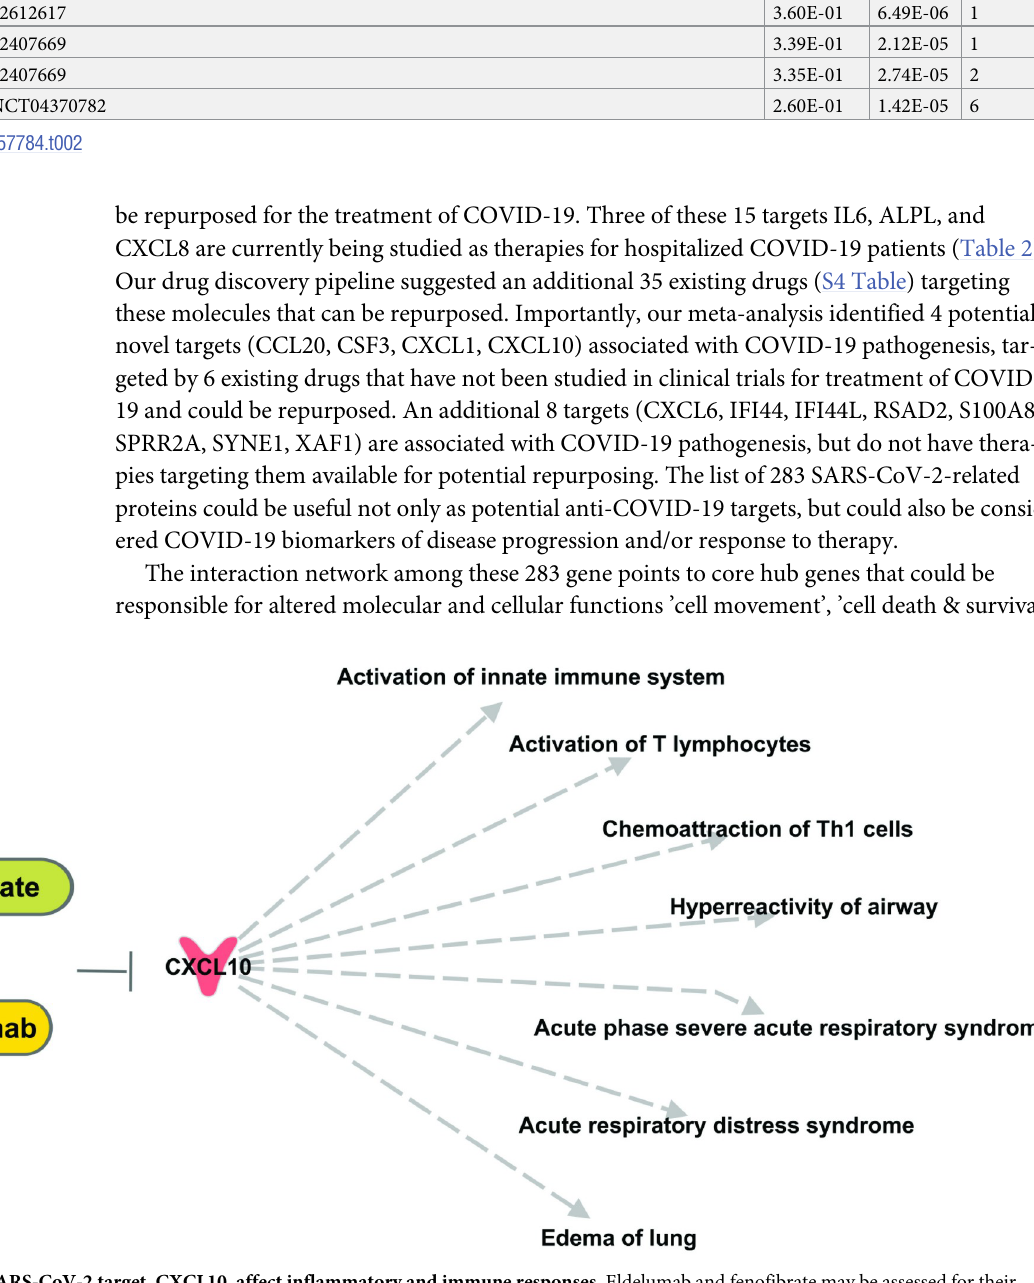
Fig 4. Top anti-SARS-CoV-2 target, CXCL10, affect inflammatory and immune responses. Eldelumab and fenofibrate may be assessed for their effects in modulating COVID-19-related lung pathology.